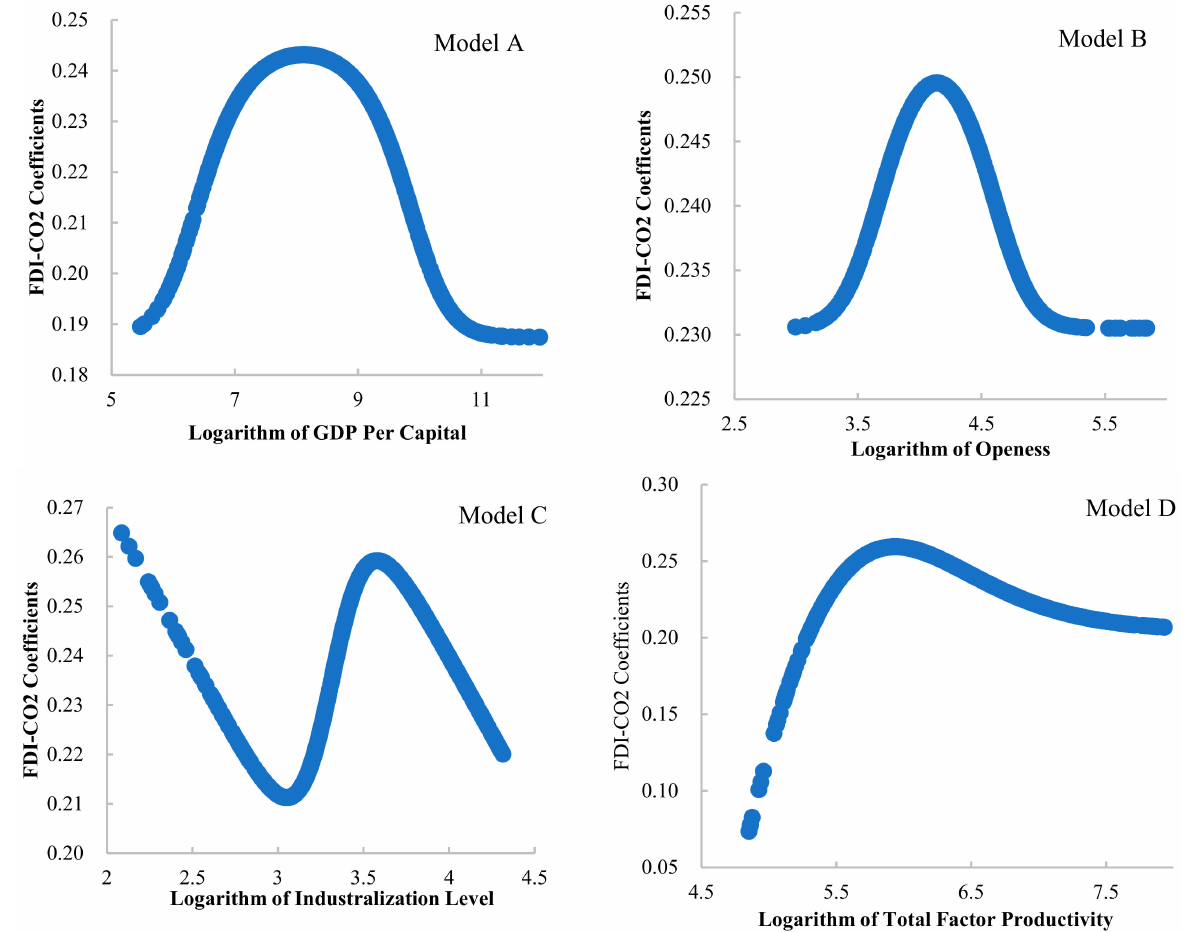
Figure 1. FDI-CO 2 coefficients estimated by PSTR models with different threshold